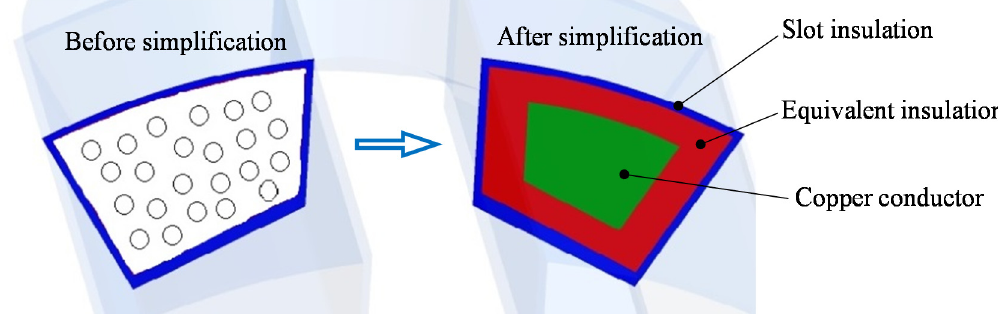
Figure 10. Simplification for the components in the stator slot.